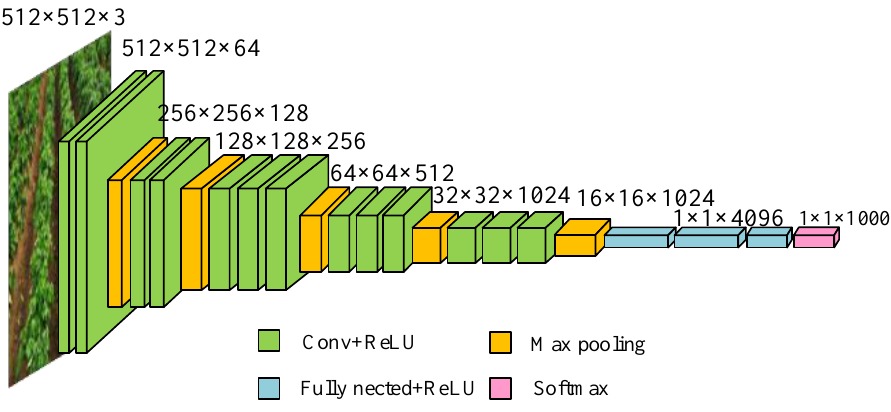
Figure 4. VGG16 net model structure.